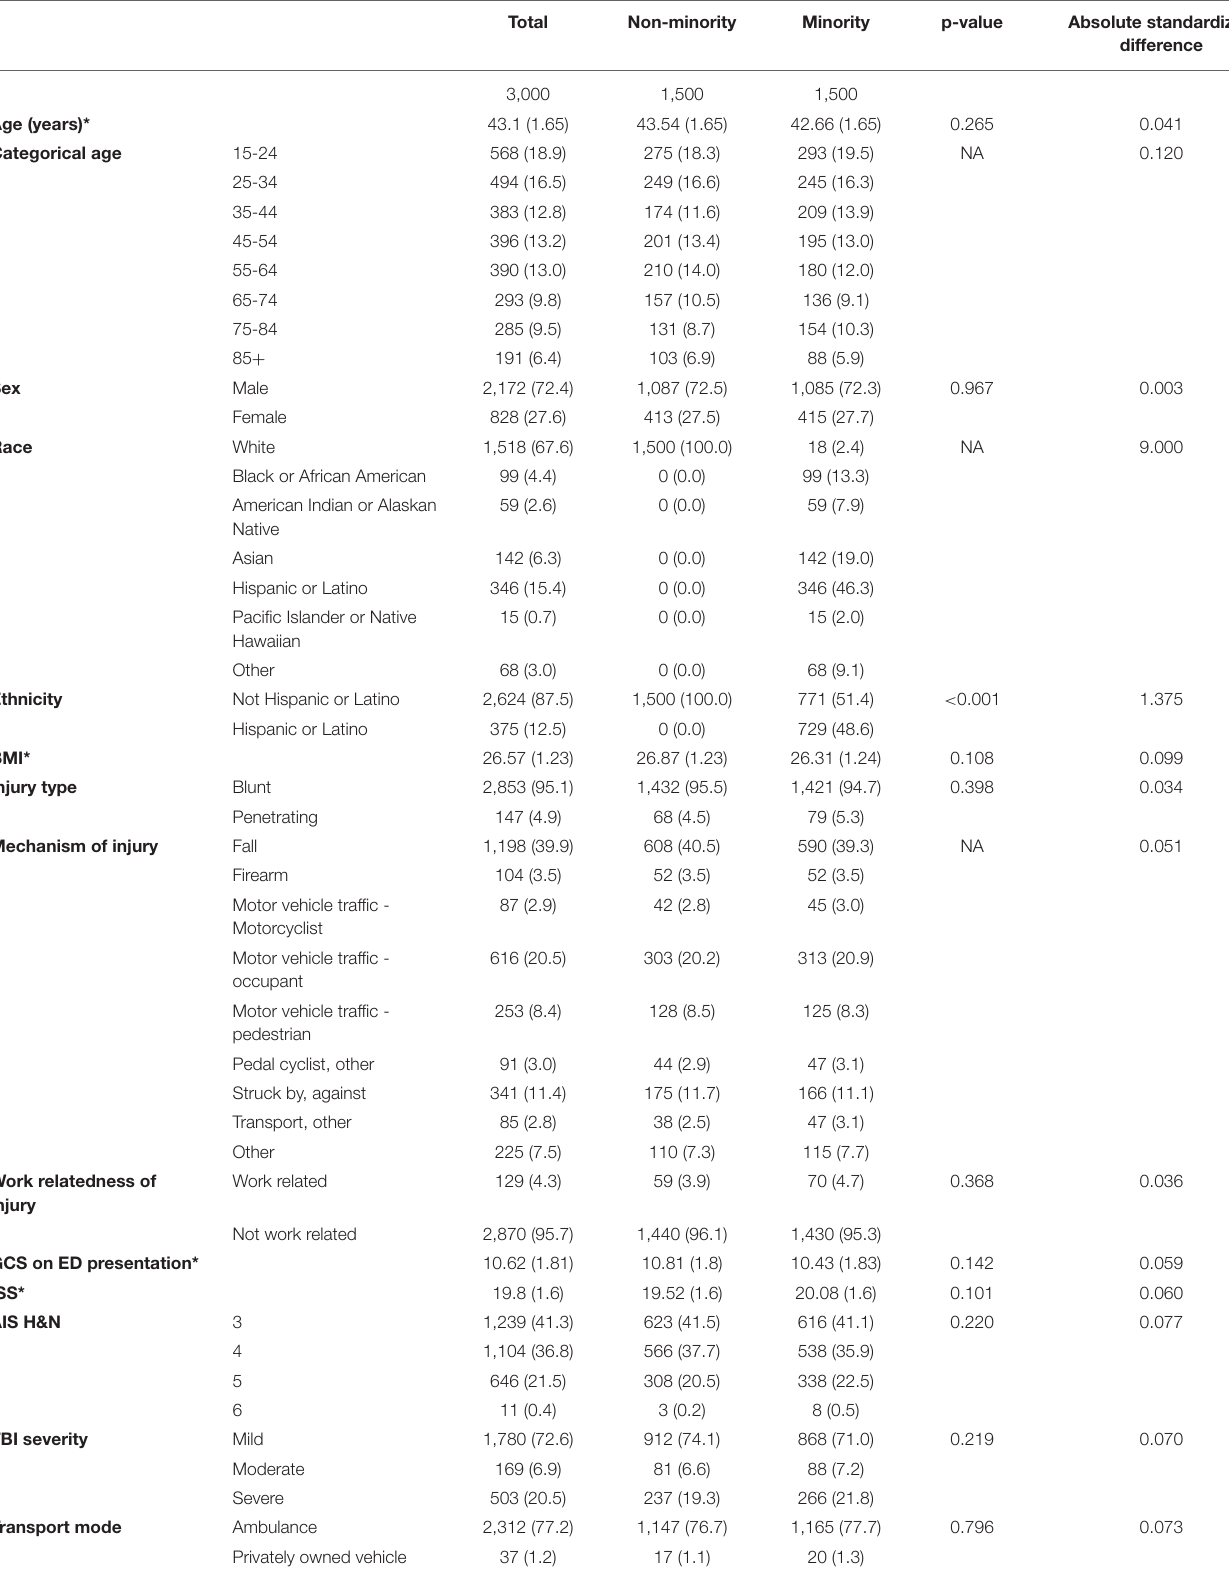
TABLE 1B | Patient characteristics stratified by minority status following propensity matching. Total Non-minority Minority p-value Absolute standardized